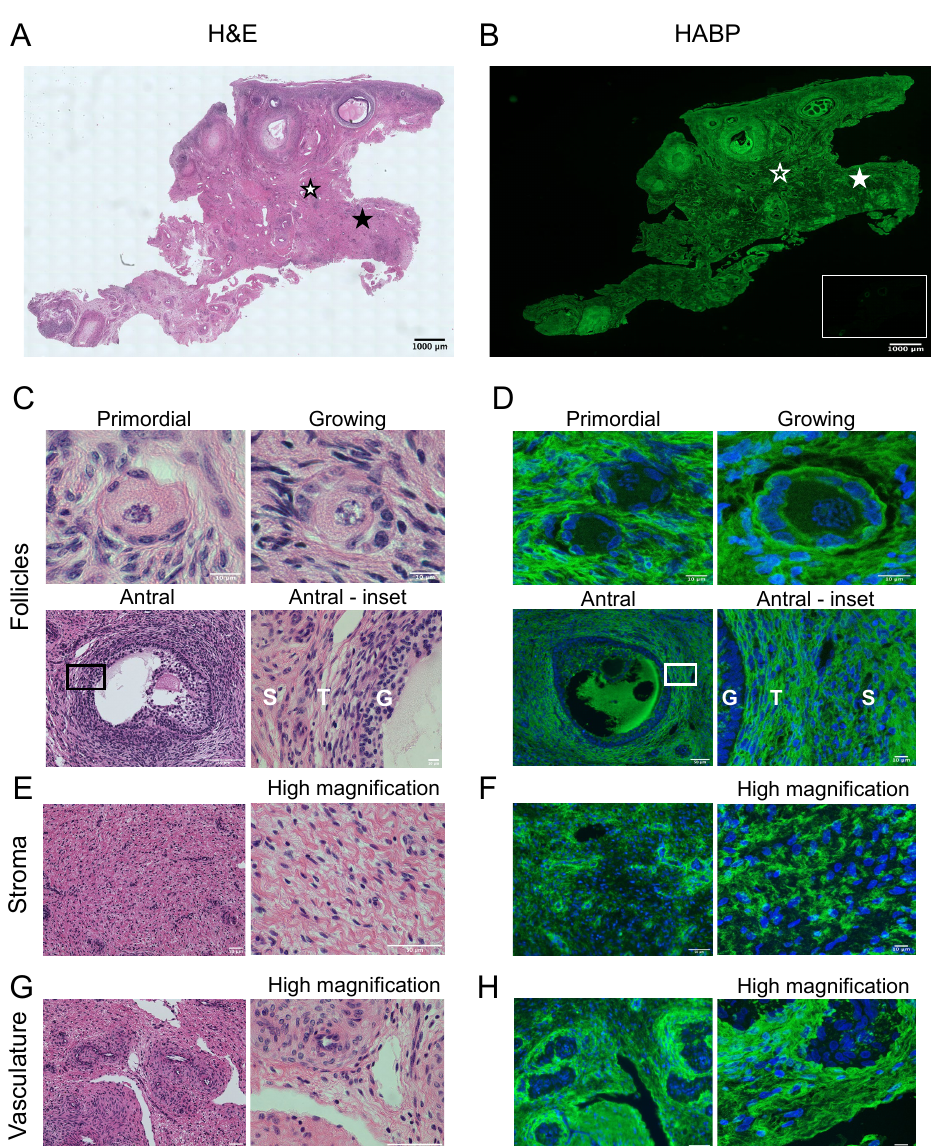
Figure 4. Bovine ovaries are hyaluronan rich. H&E staining ( left ) and HA localization ( right ) in bovine ovarian tissue sections. ( A ) H&E staining showing the microanatomical structures in the bovine ovary. ( B ) HABP staining localizing HA (green) in the bovine ovary. The inset illustrates HABP staining after pretreating a serial ovarian tissue section with hyaluronidase. ( A ) H&E and HABP stain- ing in ( C , D ) primordial follicle, growing follicle, and antral follicle, ( E , F ) stroma, ( G , H ) vasculature, respectively. The area demarcated by the black rectangles in low magnification images ( C , D —Antral follicle) is shown in higher magnification images to the right. High magnification images of stroma ( E , F ) and vasculature ( G , H ) are seen to the right of each low magnification image. For H&E images, black stars indicate location of the stroma, and white stars indicate location of the vasculature ( A ). For HABP images, the solid white star indicates location of the stroma and the star with the white outline indicates location of the vasculature ( B ). G—granulosa cell layer, T—theca cell layer, S—stroma. The scale bars are ( A , B ) 1000 µ m and ( C , D ) primordial follicle 10 µ m, antral follicle 50 µ m, antral-inset 10 µ m. ( E , G ) 50 µ m, ( F , H ) HABP staining 50 µ m, high magnification 10 µ m. Images are representative of bovine ovaries ( n = 2 cows, n = 1 ovary/cow, n = 4